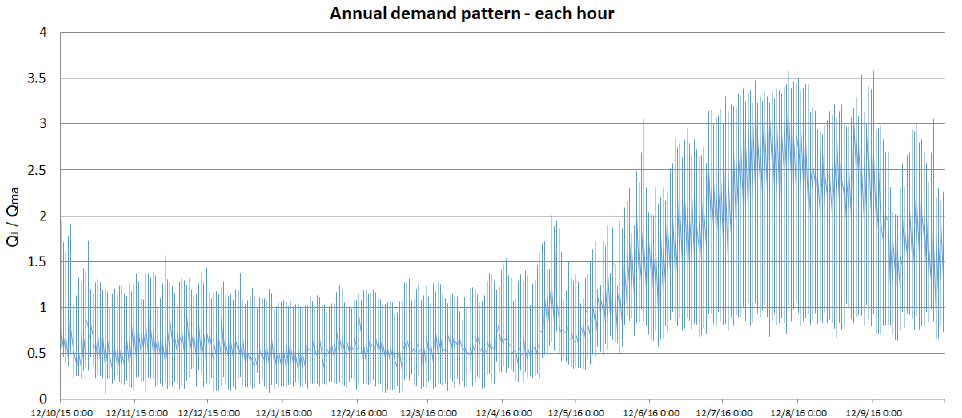
Figure 7. Annual flow pattern in Beloura DMA.